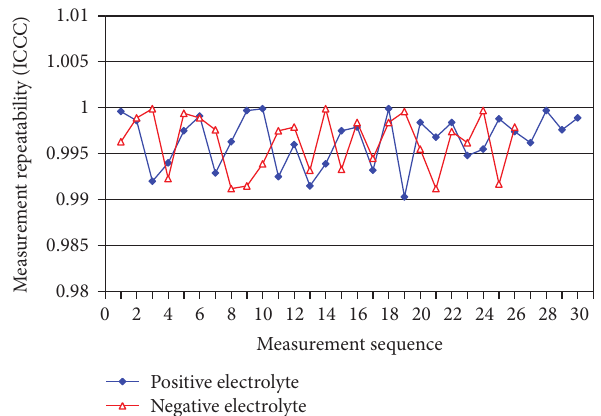
Measurement sequence Positive electrolyte Negative electrolyte F 8: e repeatability of the measurements. Each measure- ment in Figures 2(a) and 2(b) has ten detections, resulting in ten spectra. Ten spectra in the same measurement are used to calculate the intensity-corrected correlation coefficients (ICCCs) of each other. e minimum of the ICCCs from each measurement for both the positive and the negative electrolytes is plotted